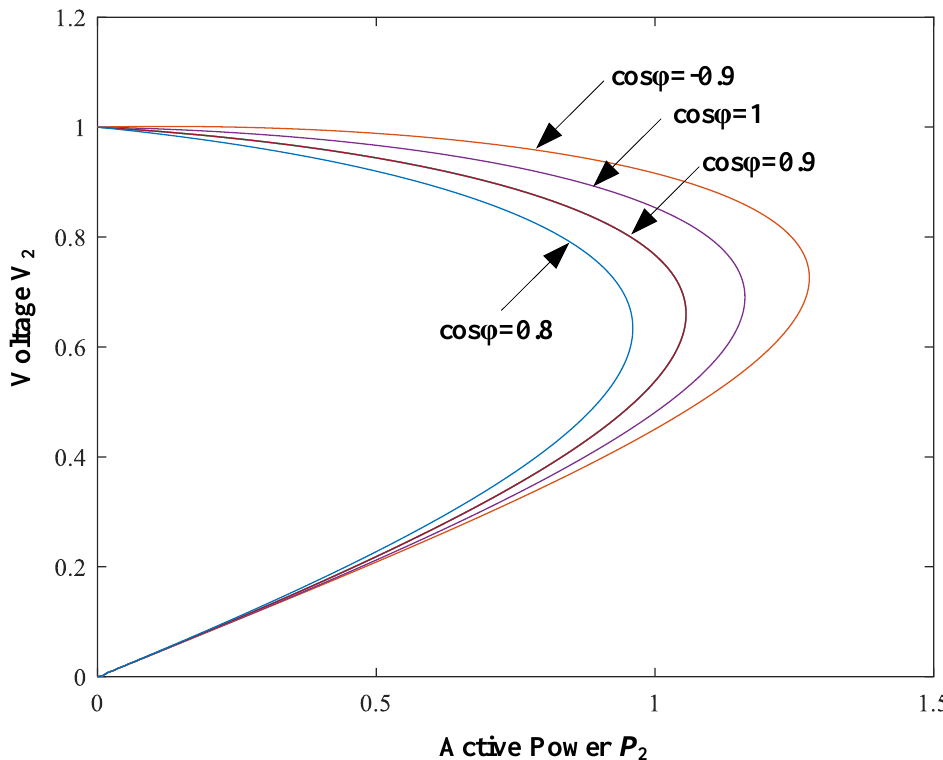
Figure 11. The P-V curves under different power factors.